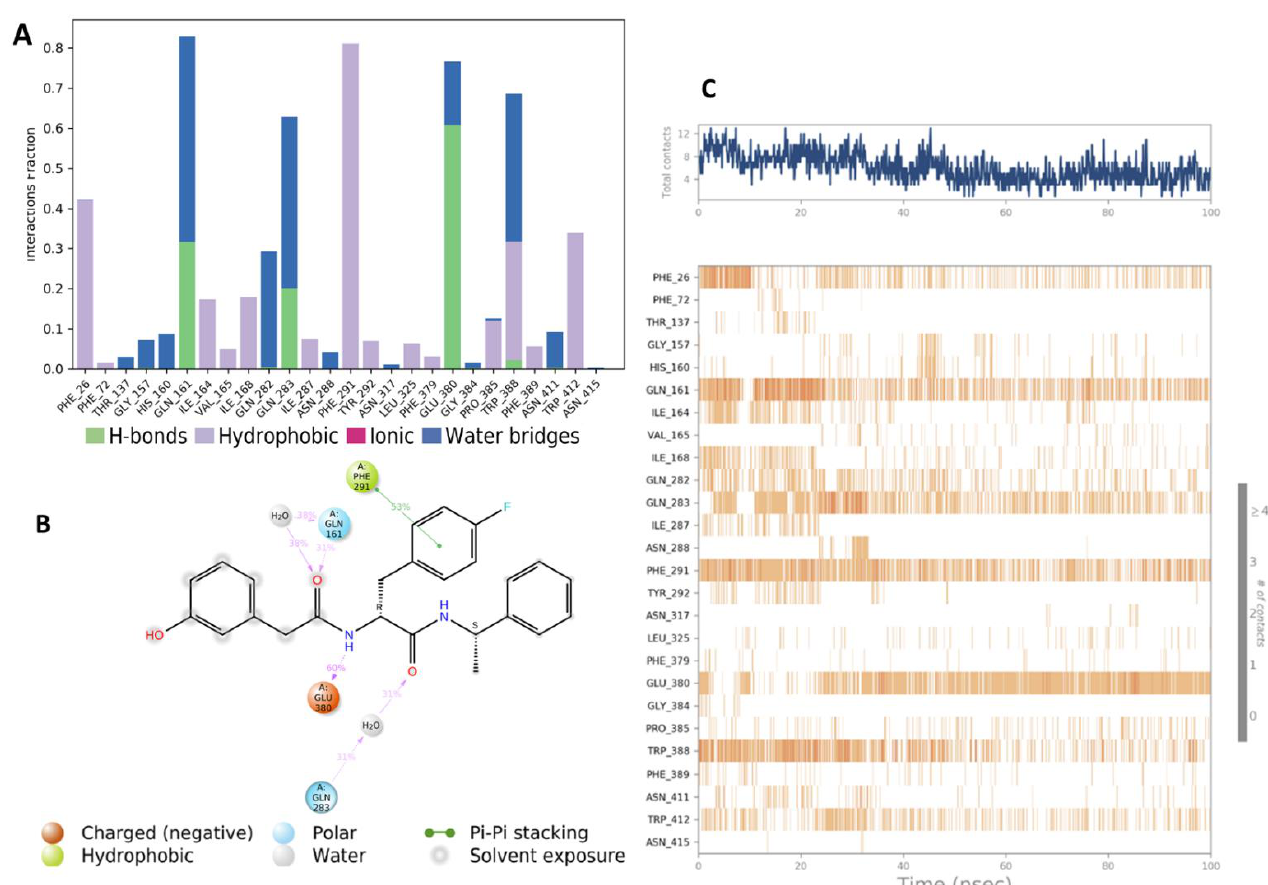
Figure 21. ( A ) The interaction of GLUT1 (PDB: 5EQG) with the native inhibitor 5RE throughout the simulation. The interactions between the ligand and protein were classified into hydrophobic, hydrogen bond, ionic, and water bridge interactions. The stacked bar charts were normalized over the course of the trajectory: for example, a value of 0.65 suggested that the interaction with the specific amino acid residue was maintained during 65% of the simulation time. Values over 1.0 imply that some protein residue made multiple interactions of the same subtype with the ligand. ( B ) A schematic diagram showed the detailed 2D atomic interactions of 5RE with GLUT1, occurring for > 30% of the simulation time in the selected trajectory (0 through 100 ns). Interactions with > 100% occurrence meant that those residues may have multiple interactions of a single type with the same ligand atom. ( C ) A timeline representation of the GLUT1- 5RE interactions shown in ( A ). The panel at the top illustrates the total number of specific interactions that the protein has made with the compound over the course of the trajectory. The panel below illustrates which residues interacted with the ligand in each trajectory frame. The dark or orange color indicated that more than one specific interaction was seen between certain residues and the ligand. # Number of